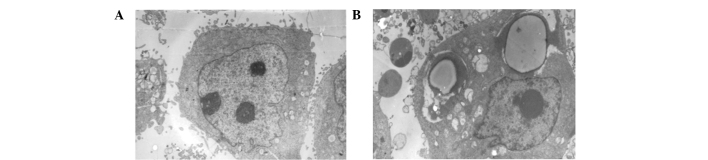
Ultra-structural alterations in LNCaP cells analyzed using a transmission electron microscope. LNCaP cells were seeded in culture bottles and treated (A) without or (B) with 0.02 mmol/l ApoG2 for 24 h.